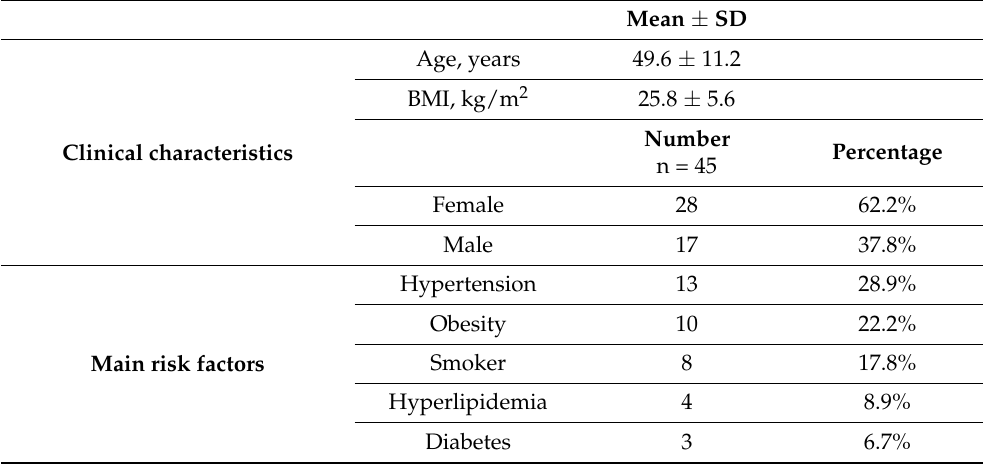
Table 1. Population clinical characteristics and main risk